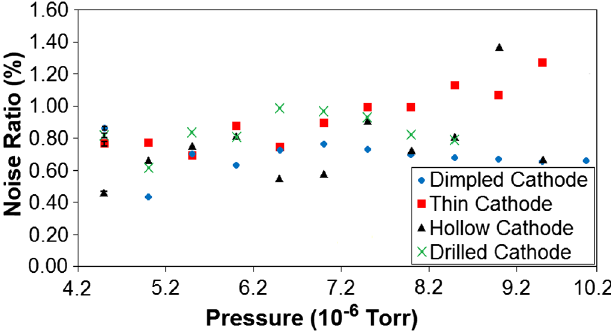
FIG. 18. Cathodes used in the ion source: (a) Standard dimpled cathode; (b) hollow cathode; (c) thin cathode; (d) drilled through cathode.